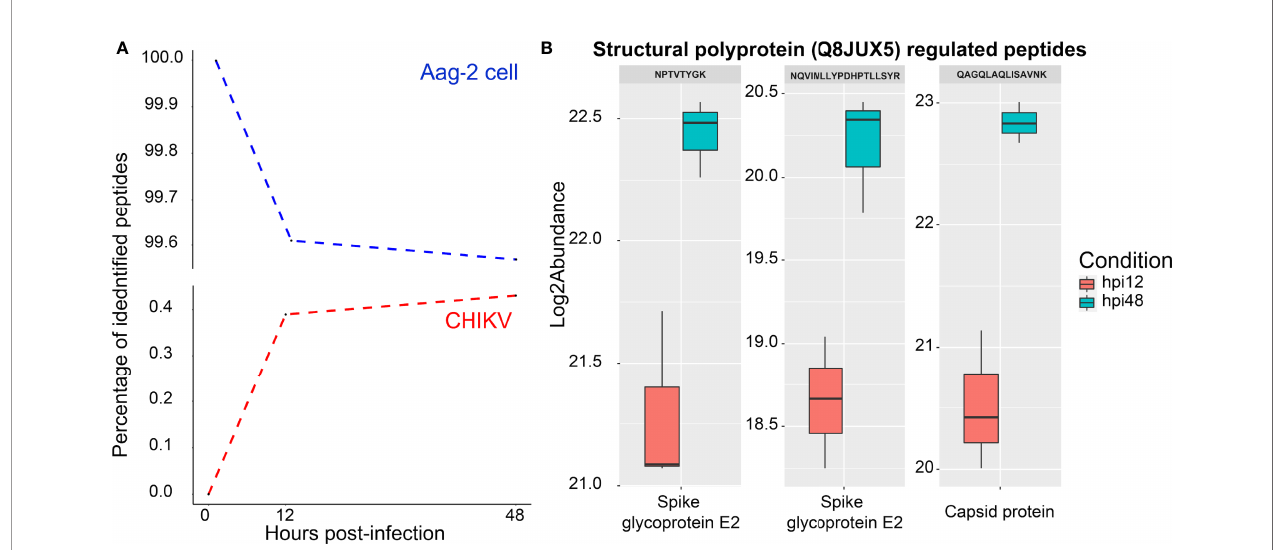
FIGURE 5 | Analysis of chikungunya virus (CHIKV) and Aedes aegypti peptides during the infection. (A) Percentage of Aedes Aegypti (blue dotted line) and CHIKV (red dotted line) identi fi ed peptides over the time points (0, 12, and 48 hpi). (B) Regulated CHIKV peptides between 12 and 48 hpi, which correspond to the E2 spike glycoprotein and the capsid protein. Those proteins are proteolytically cleaved from the structural polyprotein